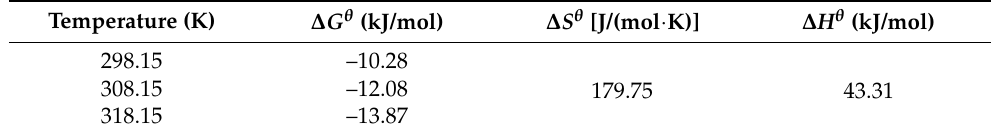
Table 4. Thermodynamic parameters.